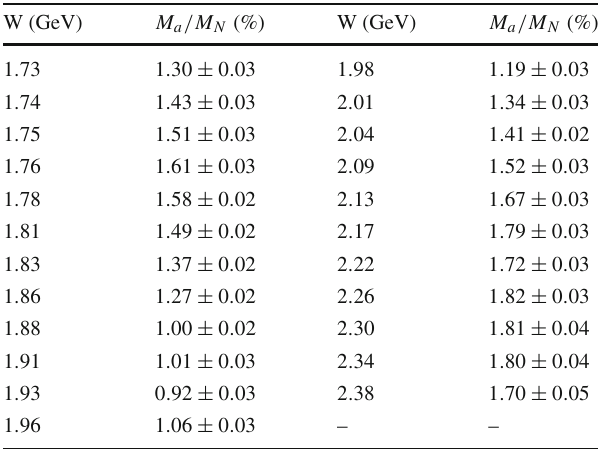
Table 5 The trace anomaly contribution extracted from the experimen- tal data of ω photoproduction [25]. The average is ( 1 . 47 ± 0 . 48 ) %